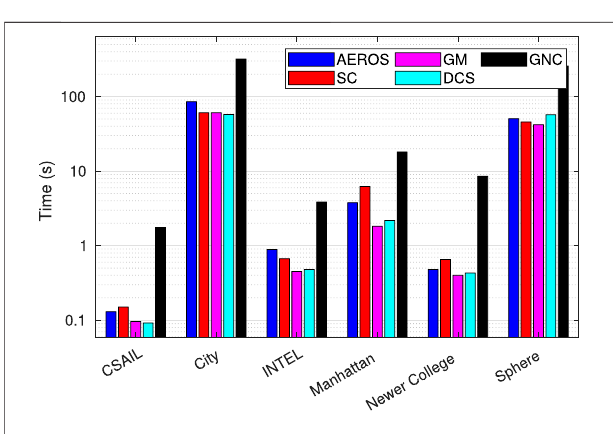
FIGURE 11 | Average computation time for the datasets used in our experiments in Section 4.1 , Section 4.2 , and Section 4.3 .